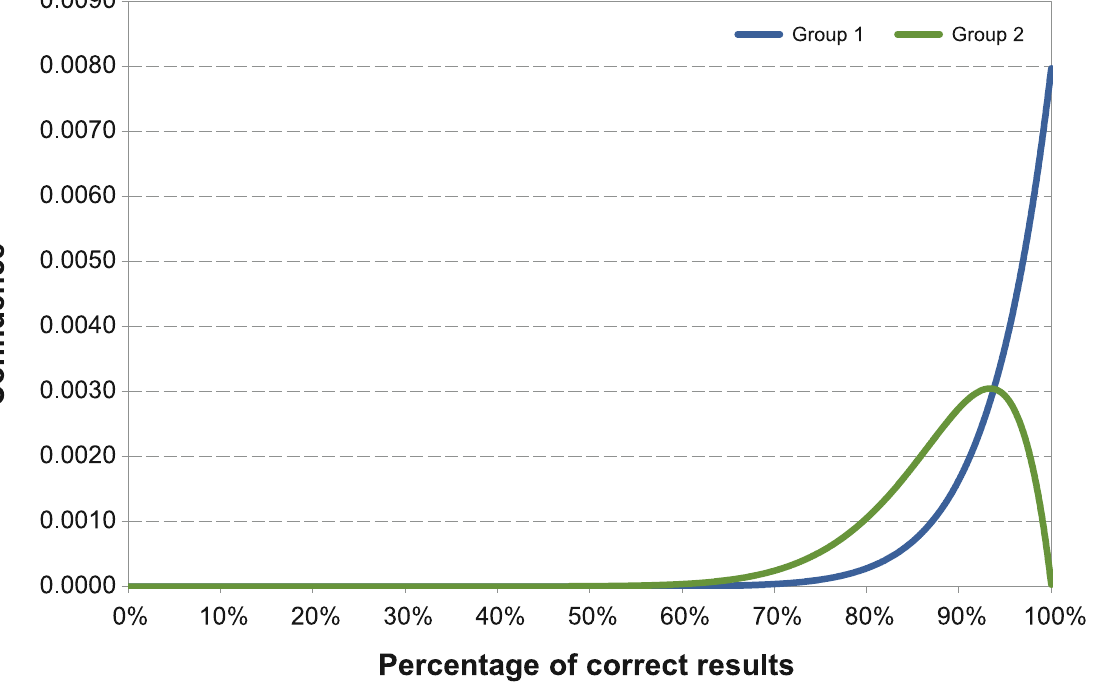
Fig 2. Distribution of the correct results of laboratories participating to the EQAs for RVF antibodies detection (IgG and IgM). Group 1 includes laboratories, which correctly classified 15 out of the 15 tested samples, Group 2 represents the laboratory failing to one test result. For IgG EQA group 1 includes the laboratories: #1, #2, #3, #4, #5, #6, #7a, #8, #9, #9a, #9b, #10, while in group 2 #7. For IgM EQA group 1 includes #1, #2, #4, #5, #6, #7, #7a, #8, #9, #9a, #9b, #10 and group 2